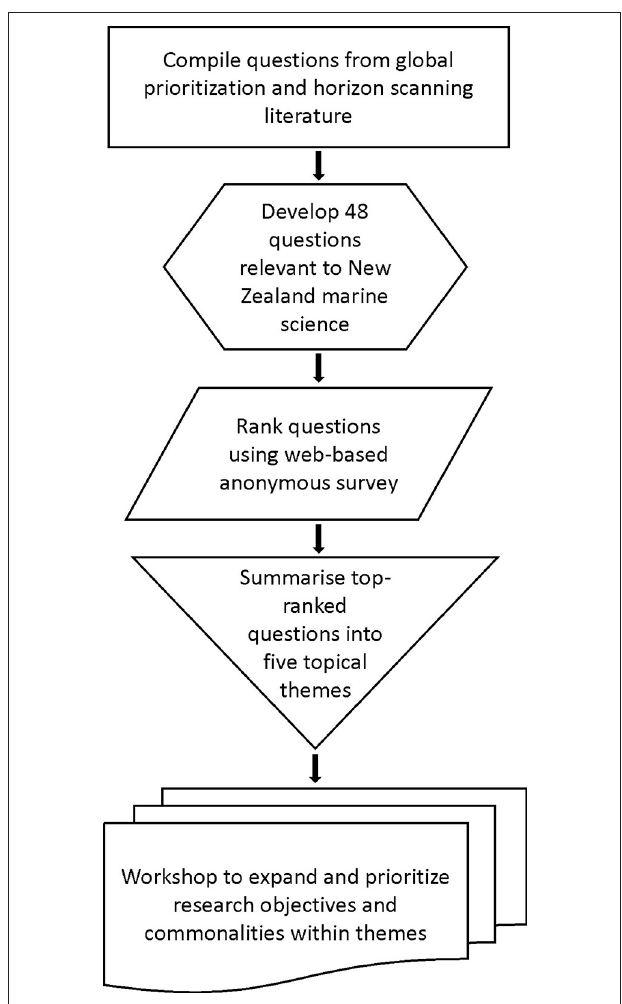
FIGURE 1 | Flowchart of New Zealand marine science prioritization